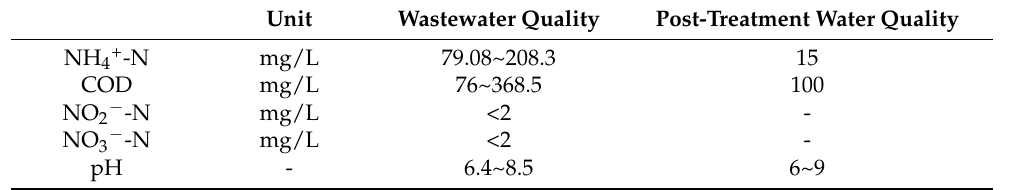
Table 1. Wastewater quality and design